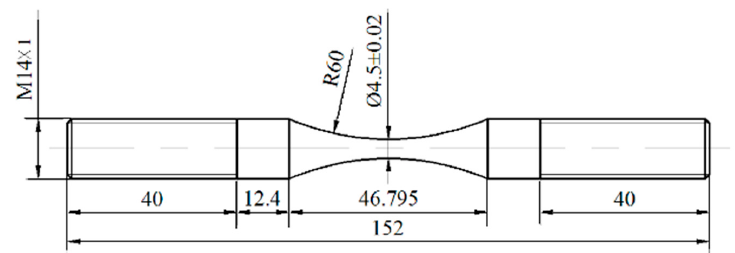
Figure 1. Shape and dimensions of specimen (units: mm).